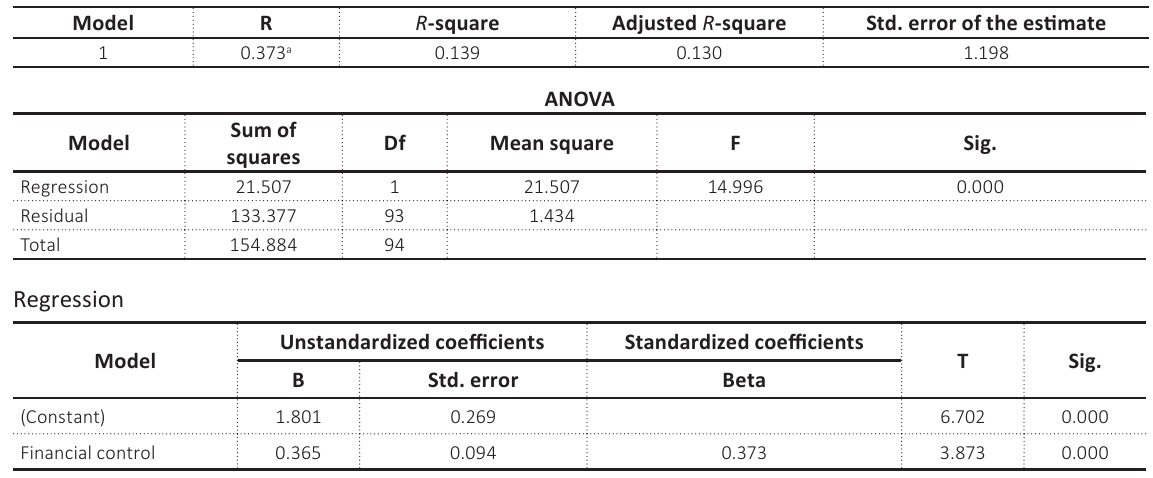
Table 3. Regression